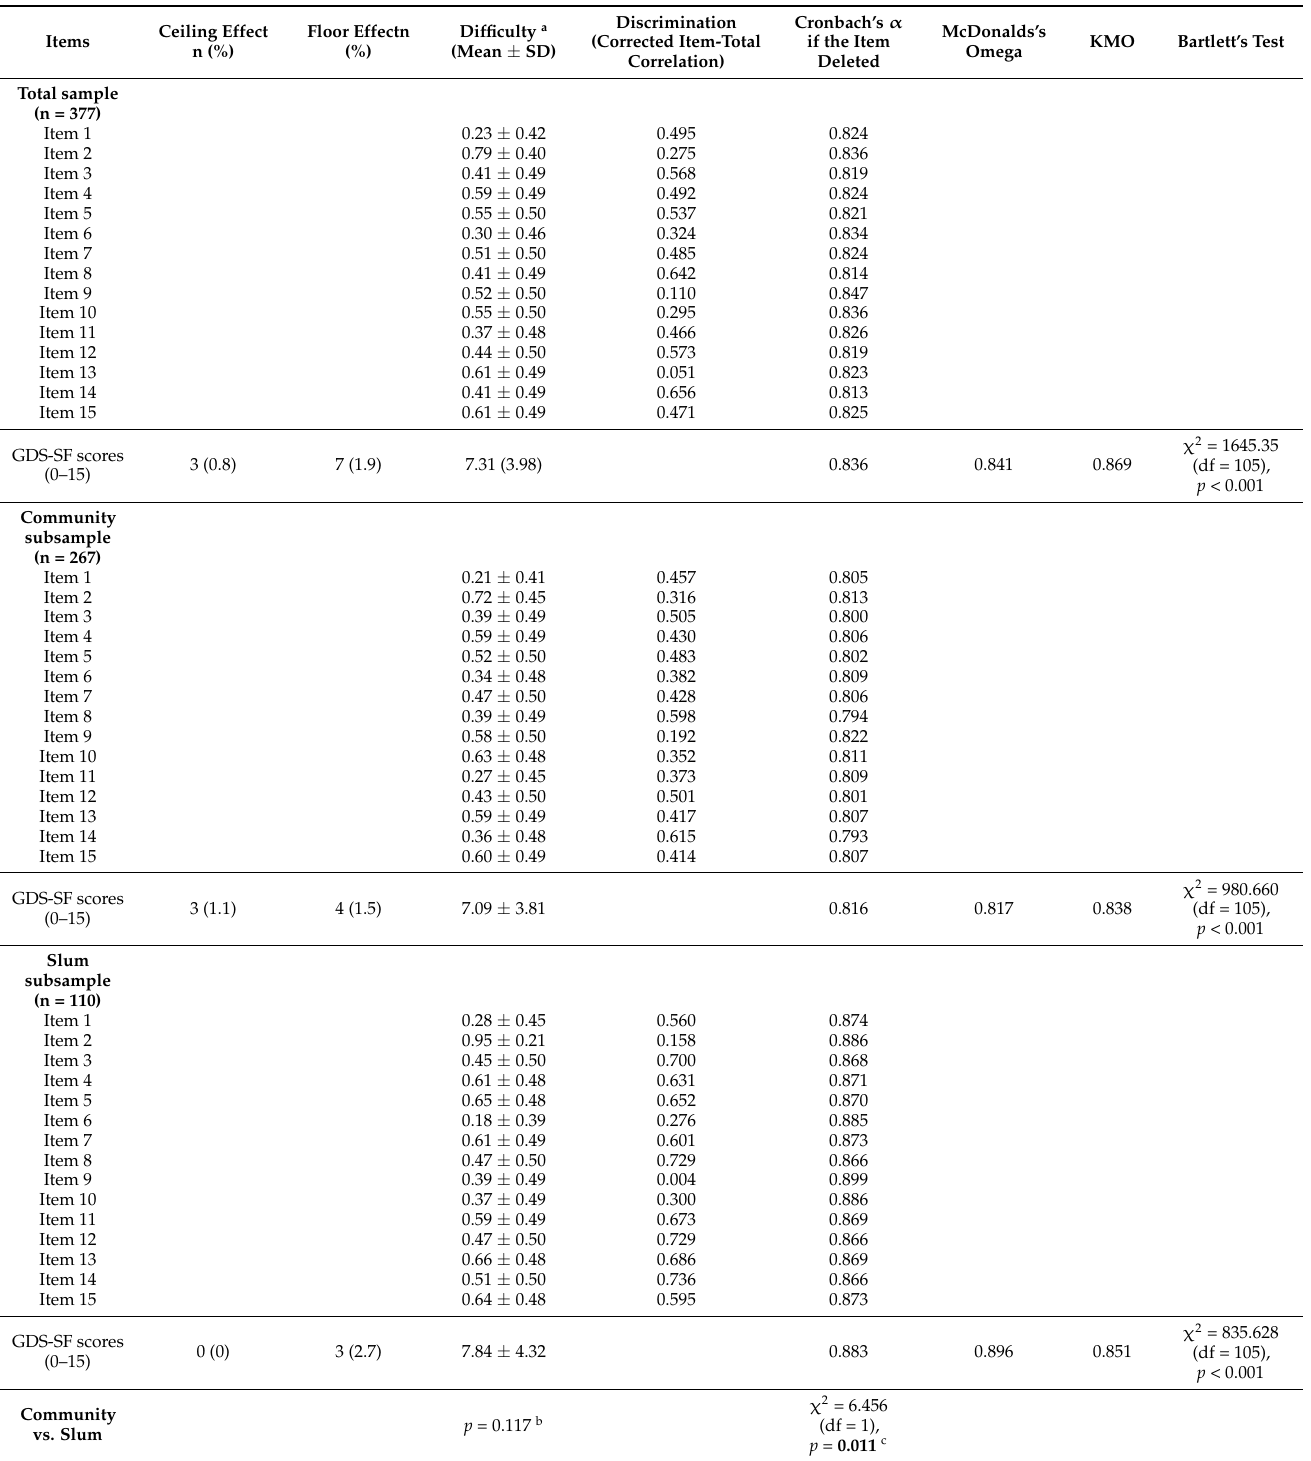
Table 2. The GDS-SF items and scale characteristics (internal consistency, construct